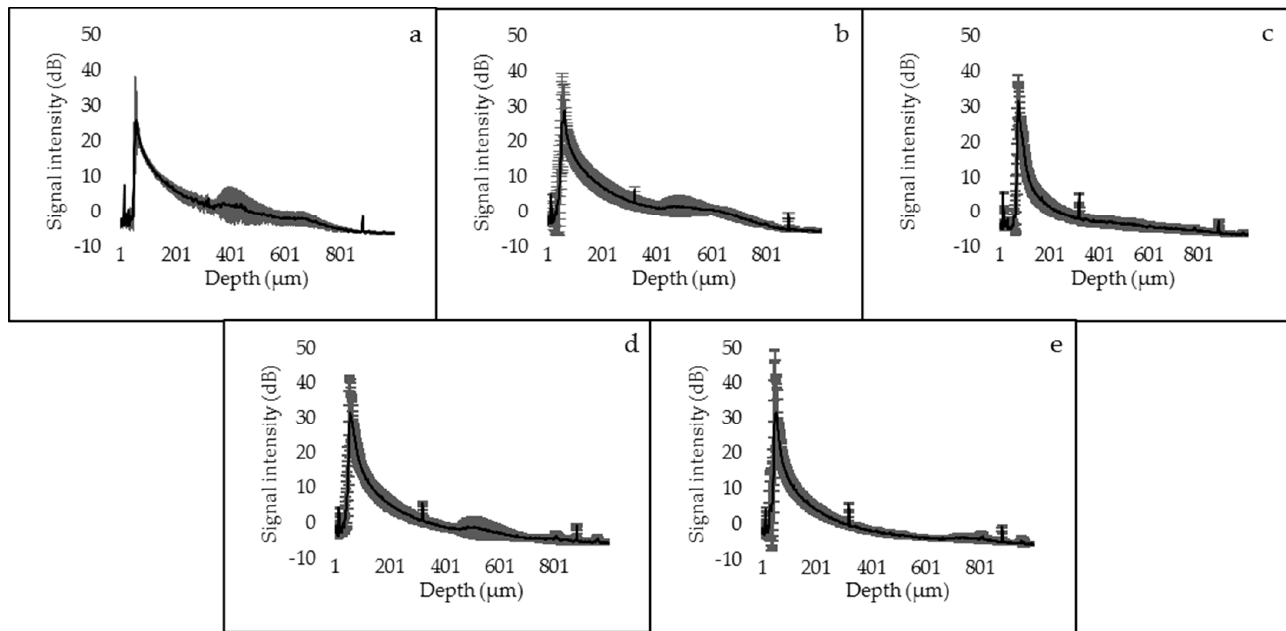
Figure 4. Signal intensity profile of each group up to 800 µm depth. The data were analyzed based on the observation results of 25 points in each group observed by SS-OCT, and a signal intensity profile of each group was created. The signal intensity of the sound group ( a ) and de3 group ( b ) suddenly dropped in the deeper parts. The signal profiles of the CS group ( d ) and NS group ( e ) showed intermediate patterns between those of the sound group ( a ) and de6 group ( c ) starting at high intensity and gradually decreasing. ( a ) Sound group, ( b ) de3 group, ( c ) de6 group, ( d ) CS group, and ( e ) NS group.